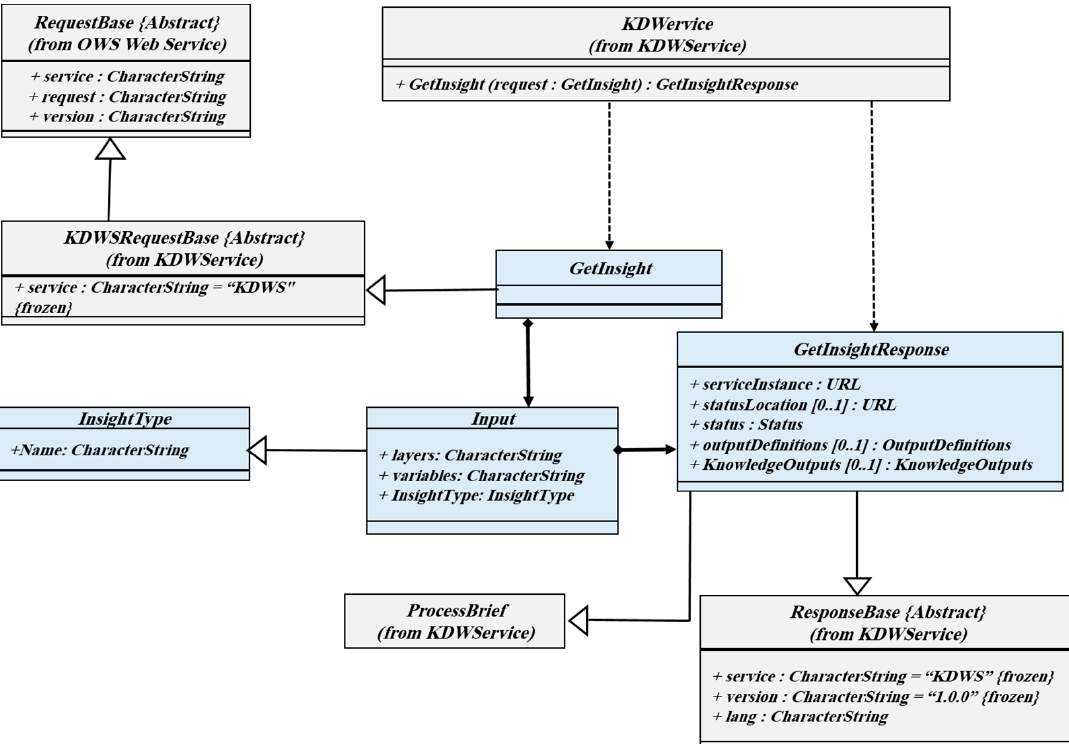
Figure 5. Interface of the GetInsight operation. Figure 5.